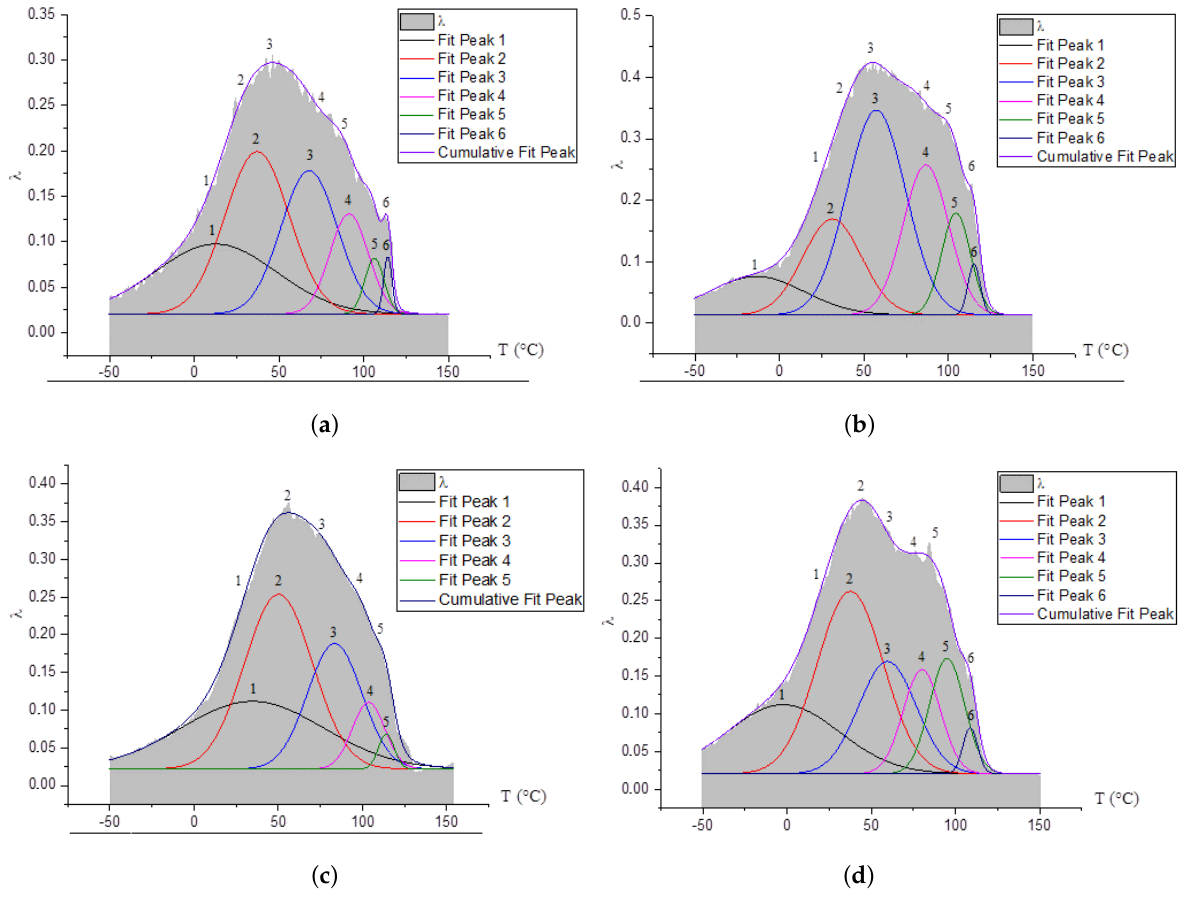
Figure 5. Decomposition of β k -peak dissipative losses by mathematical method using Gaussian normal distribution for HDPE 277-73 ( a ); HE3490-IM ( b ); CRP100 Hostalen ( c ); and Stavrolen PE4PPP-25B ( d